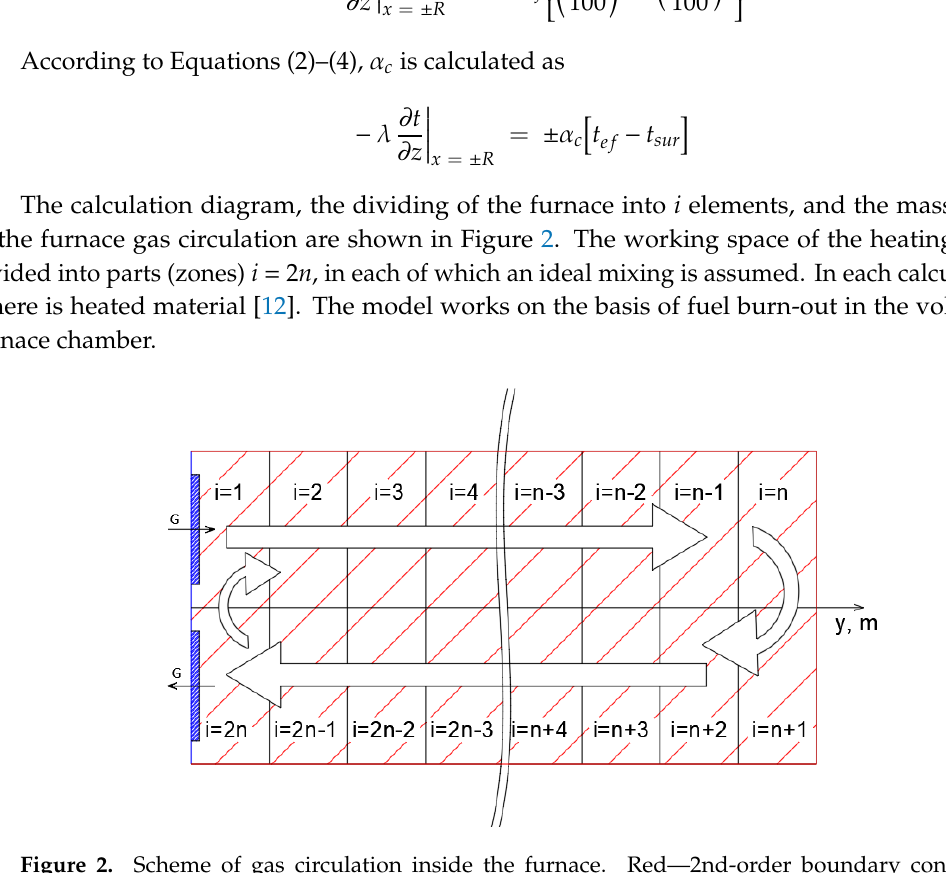
Figure 2. Scheme of gas circulation inside the furnace. Red—2nd-order boundary conditions, blue—3rd-order boundary conditions.